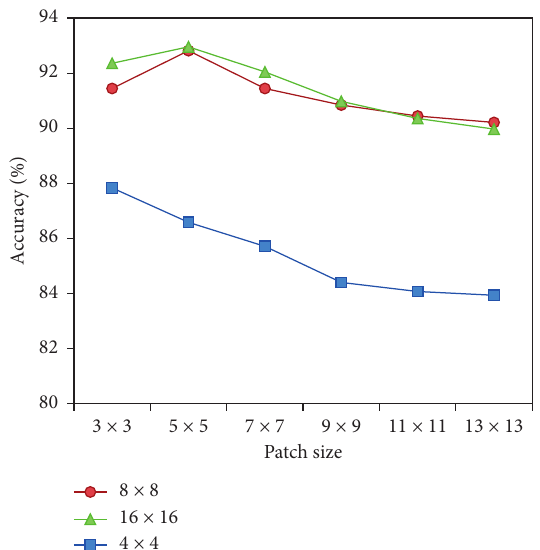
Figure 10: Influence of sampling block and histogram block on fruits boxes recognition.